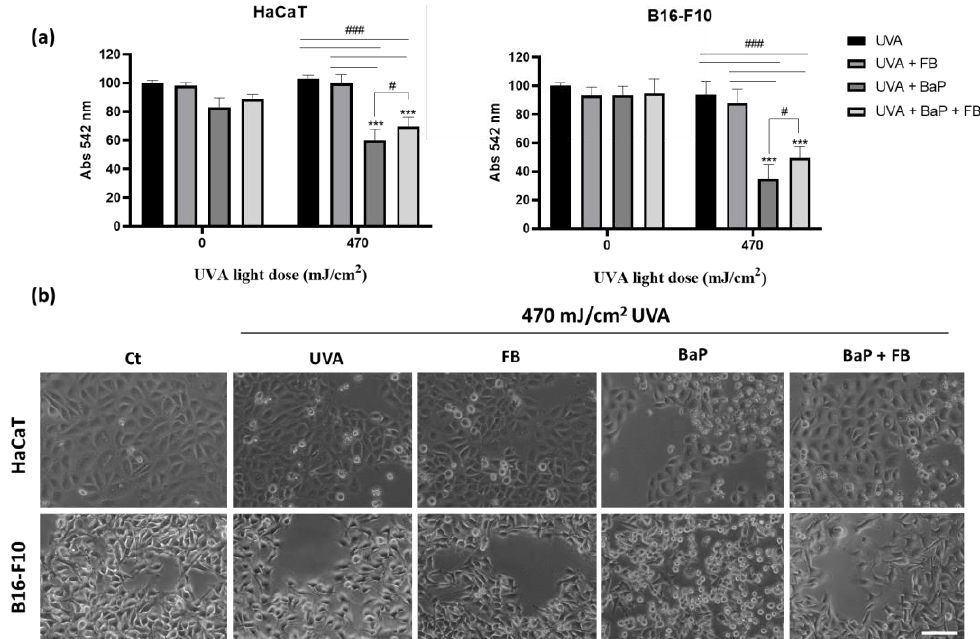
Figure 2. Effects of BaP, FB and UVA light exposure on the viability and morphology of HaCaT and B16-F10 cell lines. ( a ) Cell viability rates of both cell lines treated with BaP (2 µM, HaCaT; 5 µM, B16-F10), FB (0.01 mg/mL) and exposed to 470 mJ/cm 2 of UVA light. The results of the MTT assay indicated that the treatment with FB exerted a photoprotective effect in both cell lines. ( b ) Phase-contrast microscopy images illustrating the changes in cell morphology after the treatments. When treated with FB, a reduction in cell death could be observed compared to cells treated only with BaP. Error bars denote ± S.E.M. ( n = 3, one-way ANOVA ***: p < 0.001; and n = 3, t -test #: p < 0.05; ###: p < 0.001). Scale bar = 50 µm.